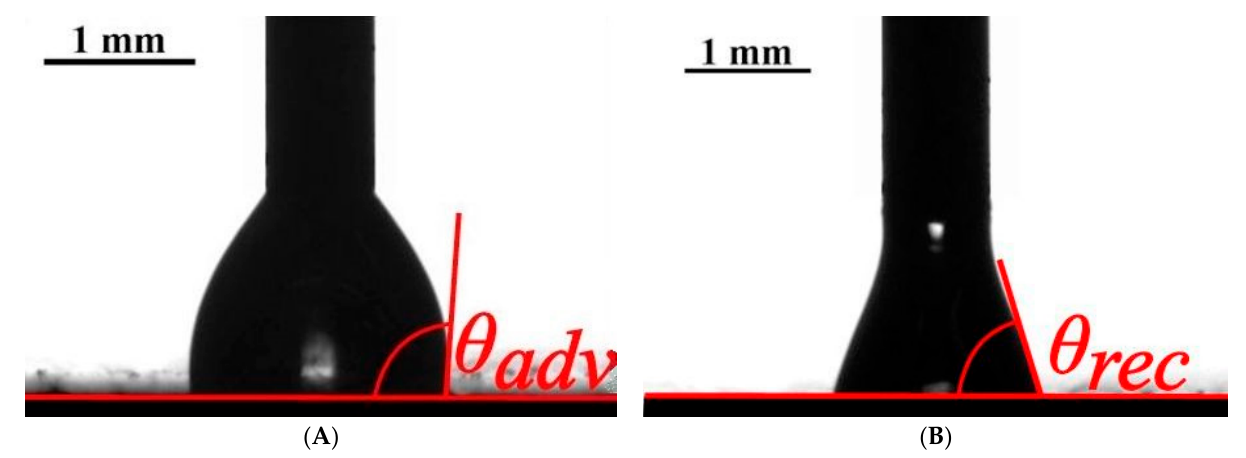
Figure 3. Establishment of the contact angle hysteresis on the pristine PVC catheter is demonstrated. ( A ) Measurement of the advancing contact angle is shown. ( B ) Measurement of the receding contact angle is depicted.